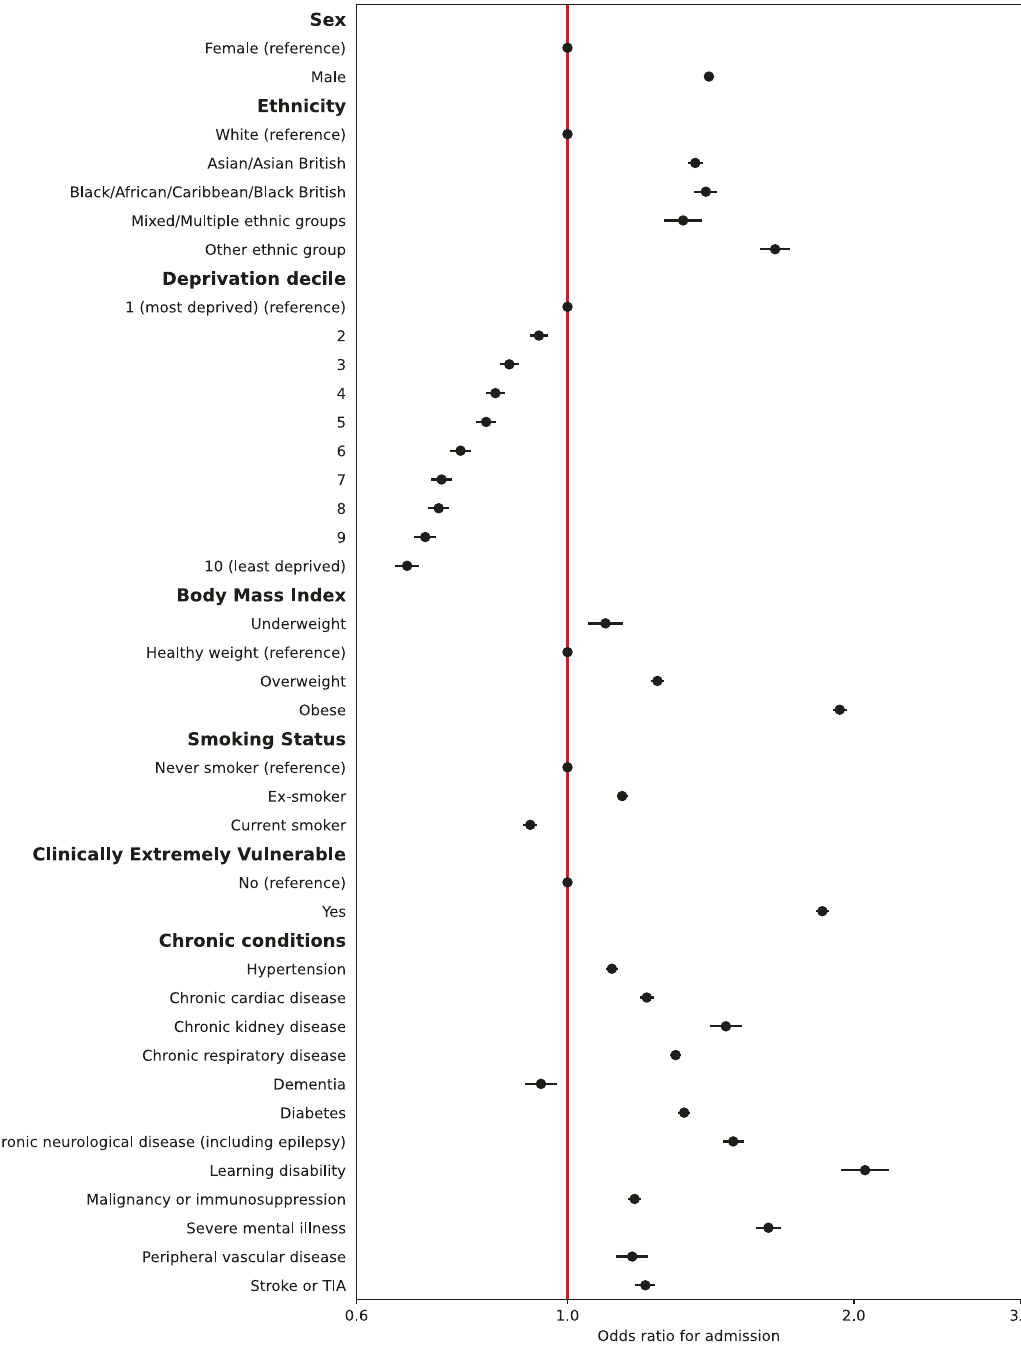
Fig. 1 Adjusted odds ratios for emergency hospital admission within 28 days of positive Covid-19 test. Circles represent odds ratios and error bars represent the 95% con fi dence intervals for patient-level predictors from multivariable mixed effects logistic regression models ( N =